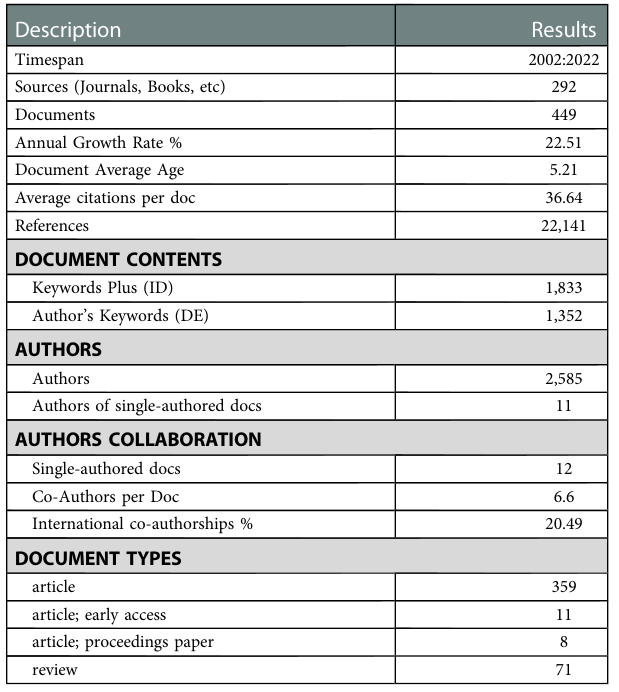
TABLE 1 Descriptive data of retrieved information about HTS associated with chronic wound.